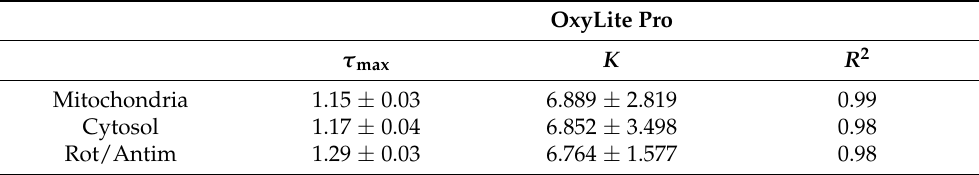
Figure 1. ( a ) Average fluorescence lifetime of Myo-mCherry in the cytosol and mitochondria of respiring and non-respiring (rotenone/antimycin treated) HeLa cells plotted versus medium pO 2 values obtained from Oxylite Pro measurements; the data are shown with the best hyperbolic fit obtained from Equation (1). ( b ) The apparent intracellular pO 2 versus the medium imposed pO 2 ; error bars are the standard deviations. Pseudocolor mapping of Myo-mCherry lifetime (or pO 2 ) in the cytosol (left) and mitochondria (right) of HeLa cells at atmospheric pO 2 of ( c ) 18.6% and ( d ) 0.5%. In the color bars, red indicates lower lifetime and pO 2 values, whereas blue indicates higher values. Table 1. Parameters of the hyperbolic fits. Parameter K was obtained from fitting the data presented in Figure 1a to Equation (1). τ max is the longest average lifetime for Myo-mCherry measured at O 2 = 18.6%. The imposed pO 2 values were obtained from the OxyLite Pro fiber tip measurements.